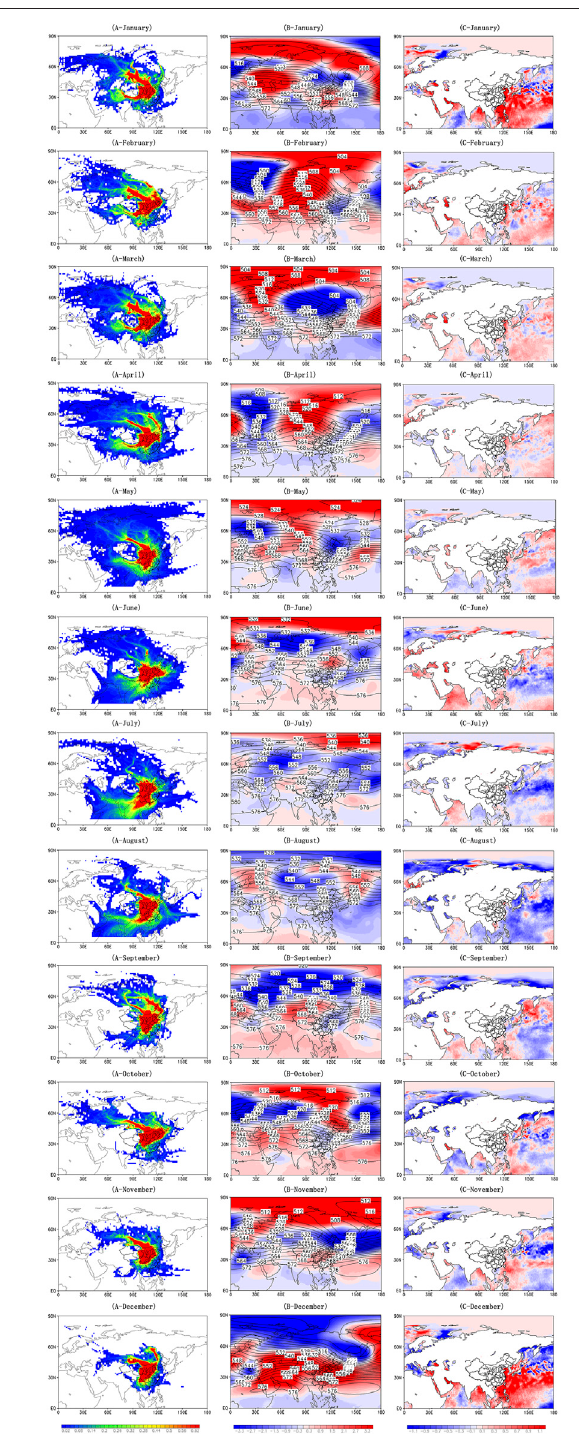
FIGURE6| Watervaporpathofthecross-seasonalstrongdroughtevents and in fl uencing factors (A) : During the month of the cross-seasonal strong drought, probabilityofwater vapor trajectoriesat lattice points(Unit:%). (B) : The characteristics of height fi eld on 500 hPa (Lines: The height fi eld average, Shadow:The height fi eldanomaly, Unit: dagpm). (C) : The characteristics of SST during the month of the cross-seasonal strong drought (Unit: ° C).